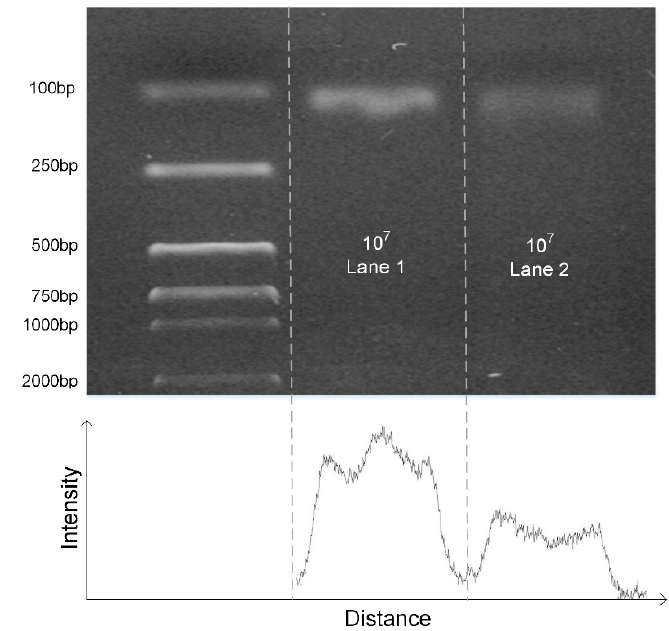
Figure 6. Electrophoretic results by commercial cycler ( lane 1 ), electrophoretic results by microdevice ( lane 2 ) and the ladder ( left ), and the intensity diagram of the polyacrylamide gel electrophoresis